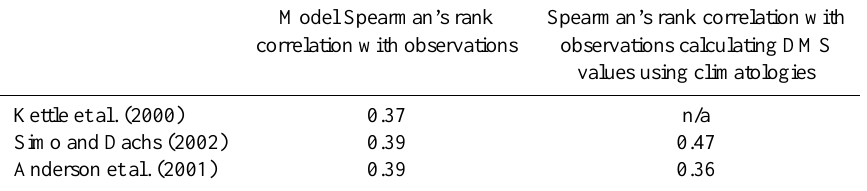
Table 1. Spearman’s rank correlation coefficients between predicted and observed surface ocean DMS concentrations, looking only at monthly data in one by one degree latitude-longitude regions where observations have been made. The observed value is the mean of all observations made at that one-by-one degree location during individual calendar months between the years 2000 and